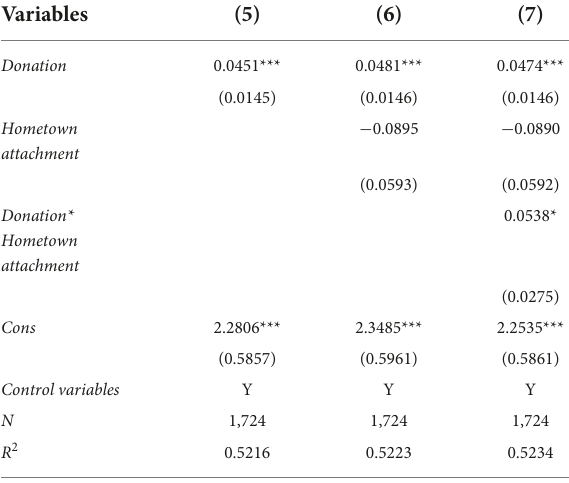
TABLE 8 Regression result of PSM treated samples. TABLE 9 Regression result of using Tobin Q as the explained variable.